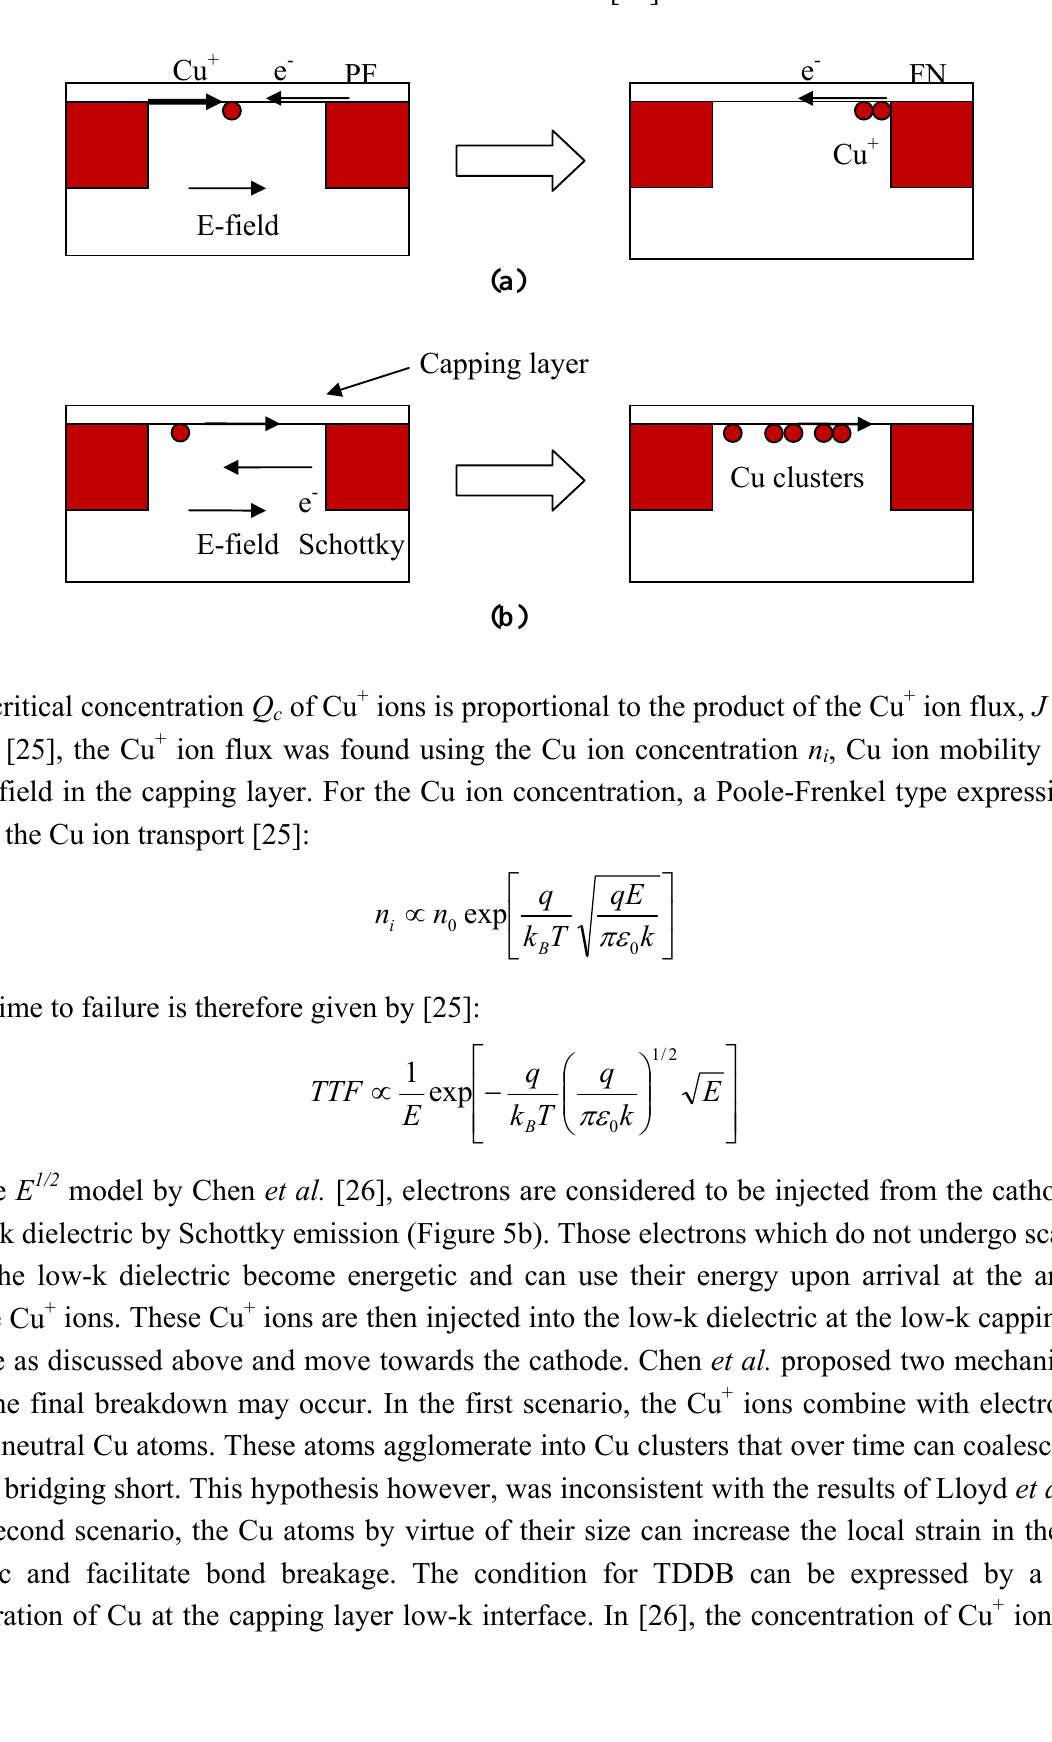
Figure 5. (a) Schematic diagram of the process leading to dielectric breakdown in the E 1/2 model of Suzumura et al. [25]; (b) Schematic diagram of the process leading to dielectric breakdown in the E 1/2 model of Chen et al.